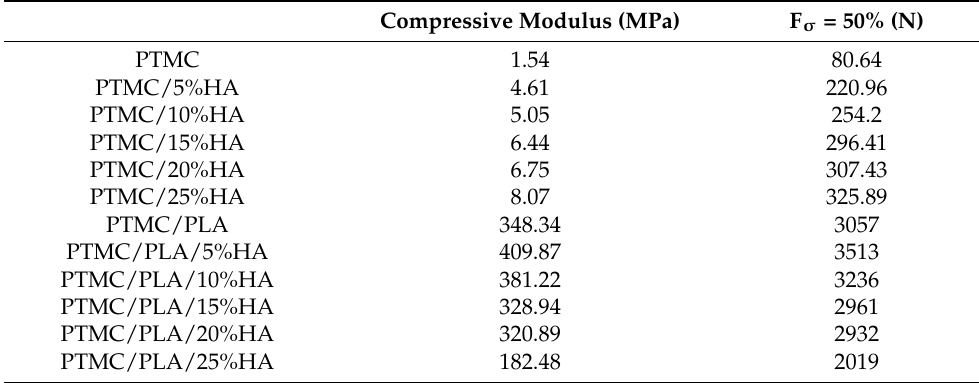
Table 3. Compressive strength and modulus of PTMC/HA and PTMC/PLA/HA